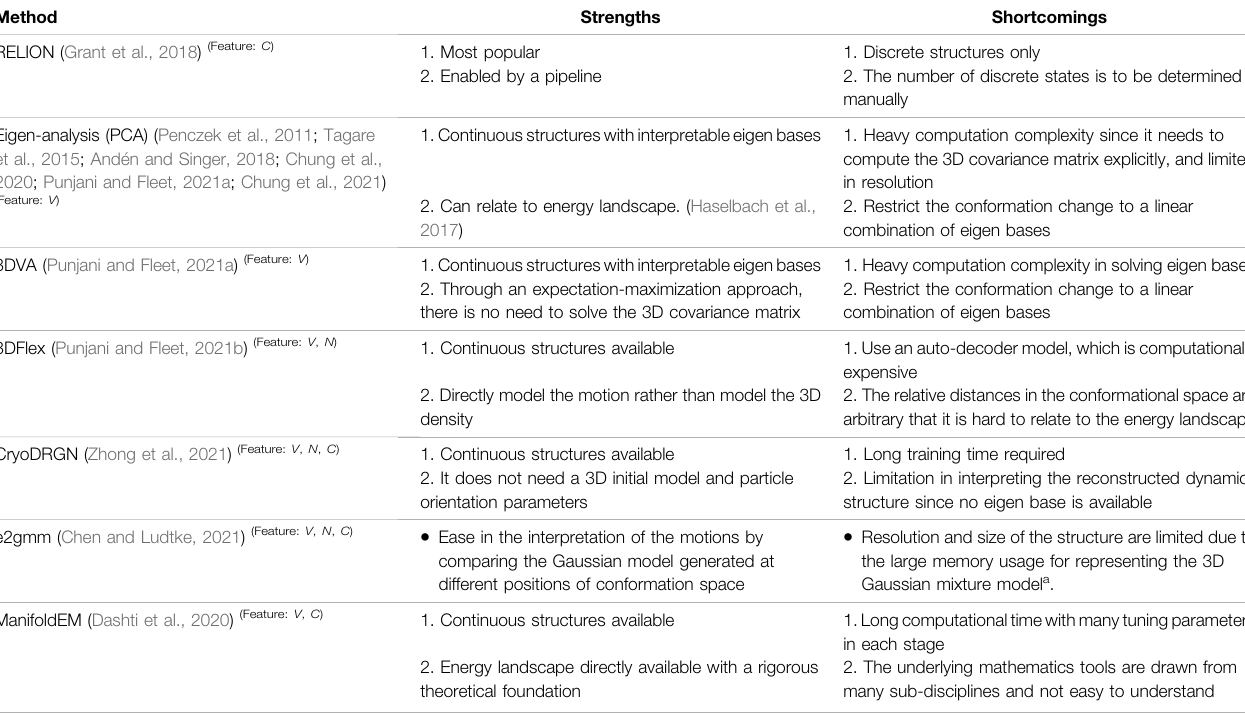
TABLE 1 | Features of various 3D classi fi cation